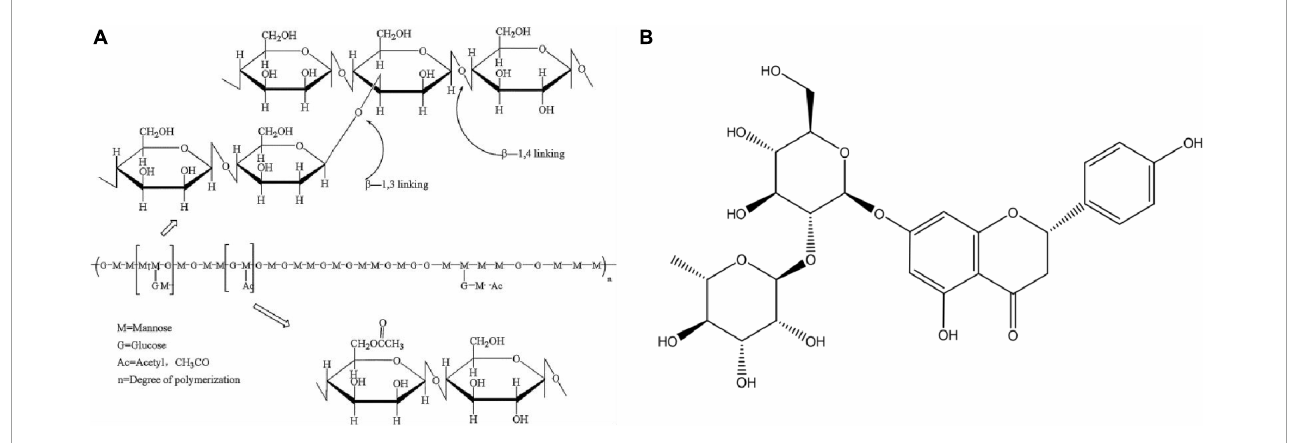
FIGURE1 The chemical structure of KGM (A) and NG (B) .